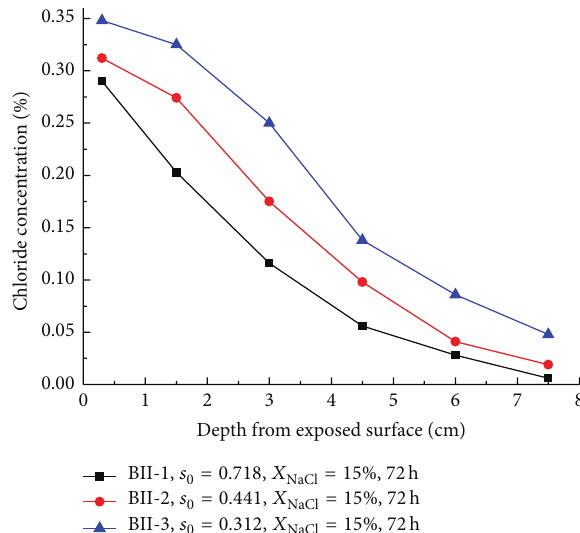
Figure 6: Chloride concentration profile under different initial saturation.